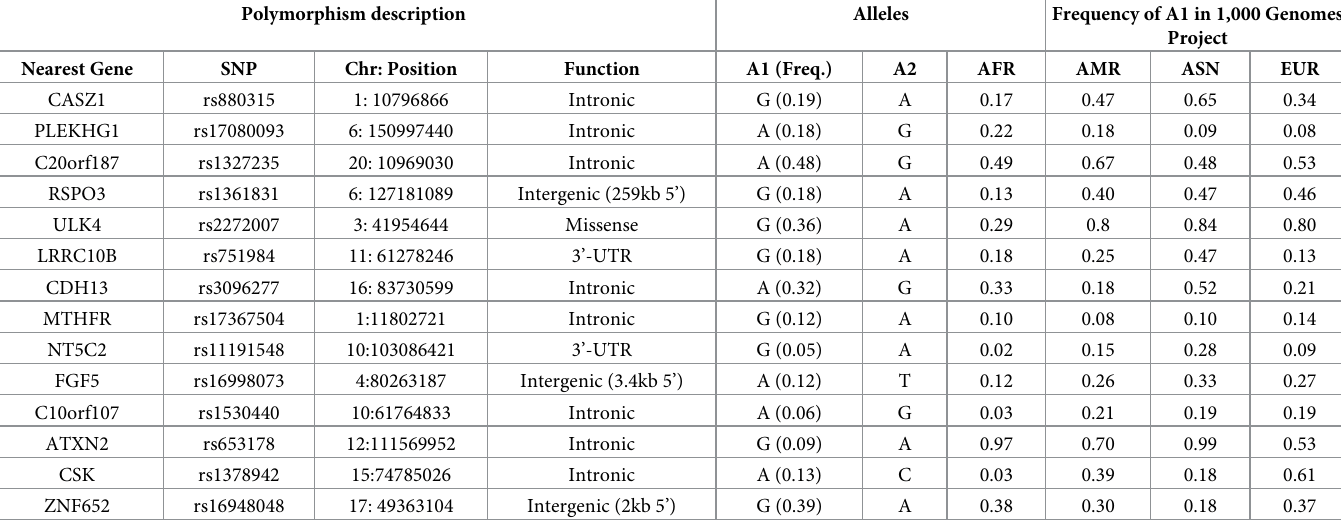
Table 1. Distribution of SNP allele frequency in study population (N = 9,534) and four different populations from 1,000 Genomes Project data. Polymorphism